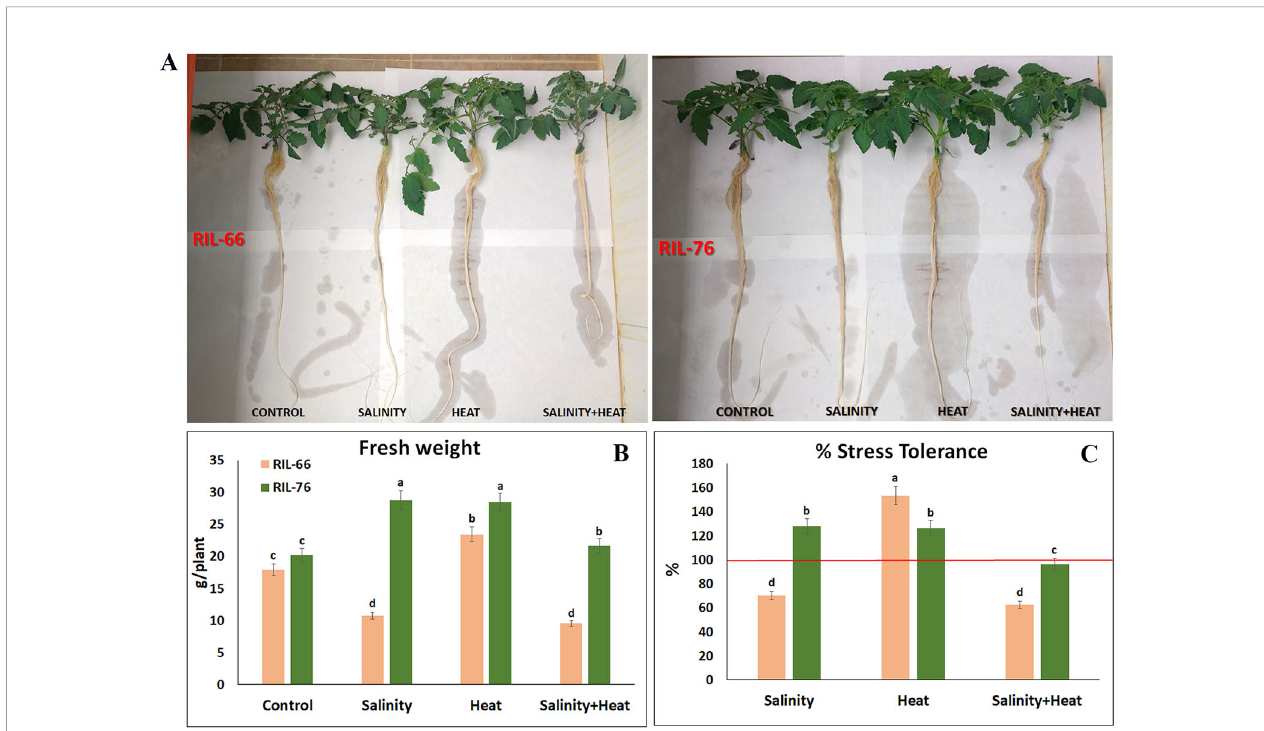
FIGURE 2 | Phenotypes and tolerance rate in tomato recombinant inbred line (RIL)-66 and RIL-76. (A) Phenotypes obtained in tomato RIL-66 and RIL-76 under control, salinity, heat stress, and the combination of salinity + heat stress. (B) Fresh weight (FW) of the tomato RIL-66 and RIL-76 at the end of the experiment (15 days of treatments). (C) Percentage of tolerance to salinity, heat, and the combination of salinity and heat obtained in RIL-66 and RIL-76 respect to their controls (red line = 100% of tolerance). Bars are mean values ± SE (n = 6), and bars with different letters are signi fi cantly different at p < 0.05 according to Tukey's test. (n =